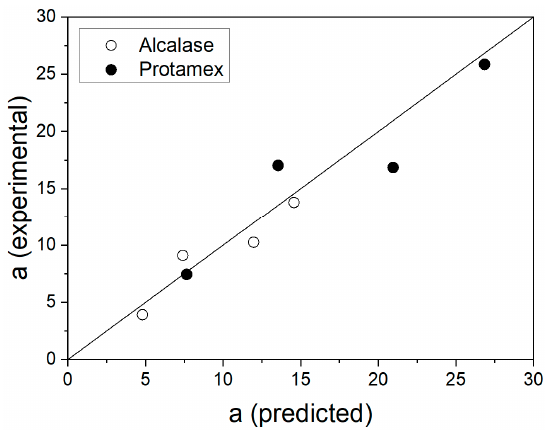
Figure 3. Correlation between predicted and experimental values of the kinetic constant a for the hydrolysis curves obtained in validation experiments with Alcalase (R 2 = 0.9830) and Protamex (R 2 = 0.9295). The correlation for both data is R 2 = 0.9528.